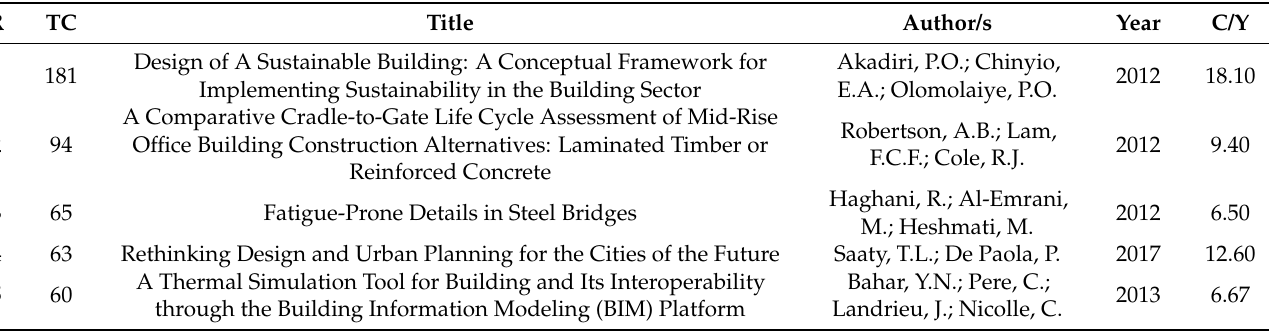
Table 2. Most cited papers (research